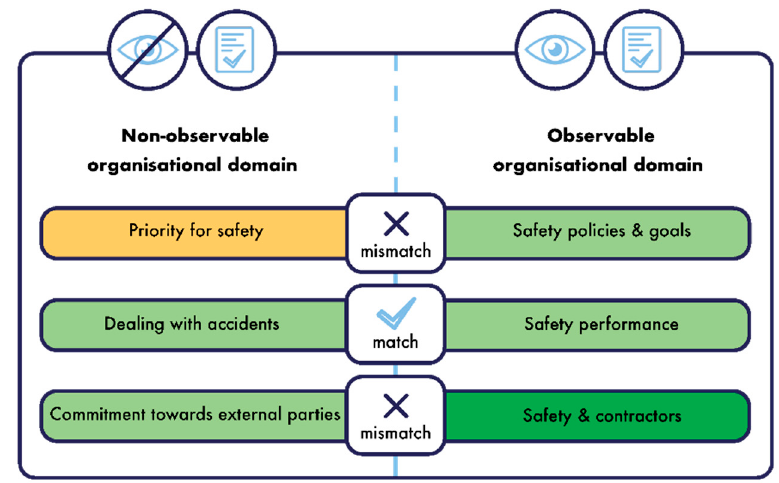
Figure 8. Example of a comparison between the results of the observable sub-domains and non- observable sub-domains.